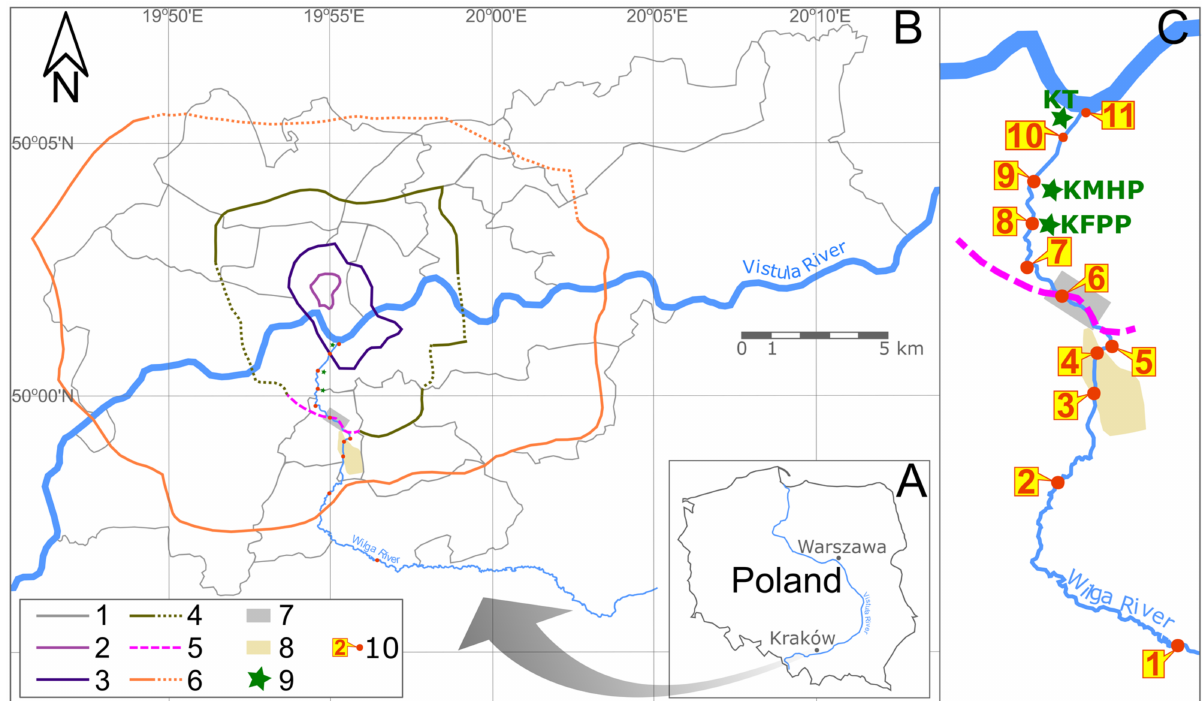
Figure 1. Study area: ( A )—location of the study area (Krak ó w city) on the map of Poland; ( B )—sampling cites at the Wilga River (in general); ( C )—sampling cites at the Wilga River (in details); 1—boundaries of the Krak ó w city and its districts; 2—first ringway of Krak ó w; 3—second ringway of Krak ó w; 4—third ringway of Krak ó w (existing sections are marked with a continuous line, while planned sections are marked with a dashed line); 5—“Łagiewnicka Route”, a section of the third ringway of Krak ó w under construction; 6—fourth ringway of Krak ó w (existing sections are marked with a continuous line, while planned sections are marked with a dashed line); 7—relocated section of the Wilga River (Figure 2); 8—waste piles of former “Solvay” Krak ó w Soda Works (Figure 3); 9—locations of chemical industry objects (KFPP—Krak ó w Fur Processing